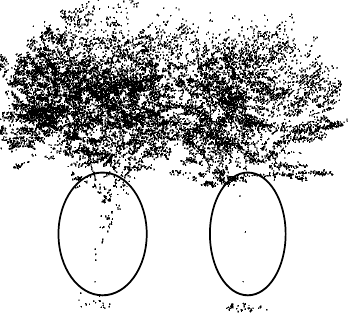
Figure 9. An example of false negative results (circles denote the occluded/missing